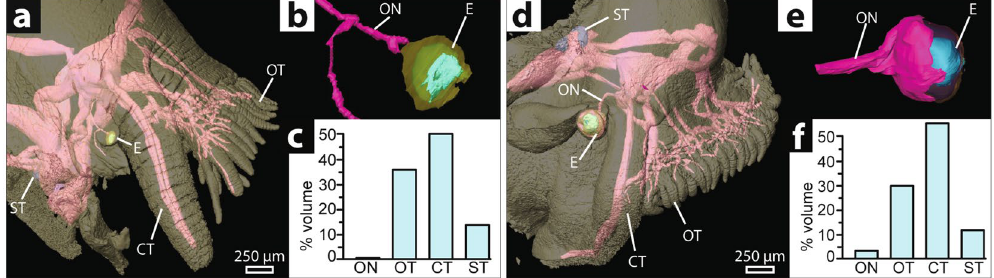
Figure 3. Sensory investment in Elaphriella wareni compared with Ilanga navakaensis . ( a – c ) E. wareni a reduced-eyed species. ( d – f ) I. navakaensis which has a typical vetigastropod eye. ( a , d ) Whole-head reconstructions. ( b , e ) Detailed reconstruction of eye. ( c , f ) Graph showing percentage of relative investment in sensory organs by volume for the optic nerve, oral tentacles and papillae (combined), cephalic tentacle and the volume of statocysts as a proxy for investment in this structure. Abbreviations: ON, optic nerve; OT, oral tentacles; CT, cephalic tentacle; ST, statocyst; E,